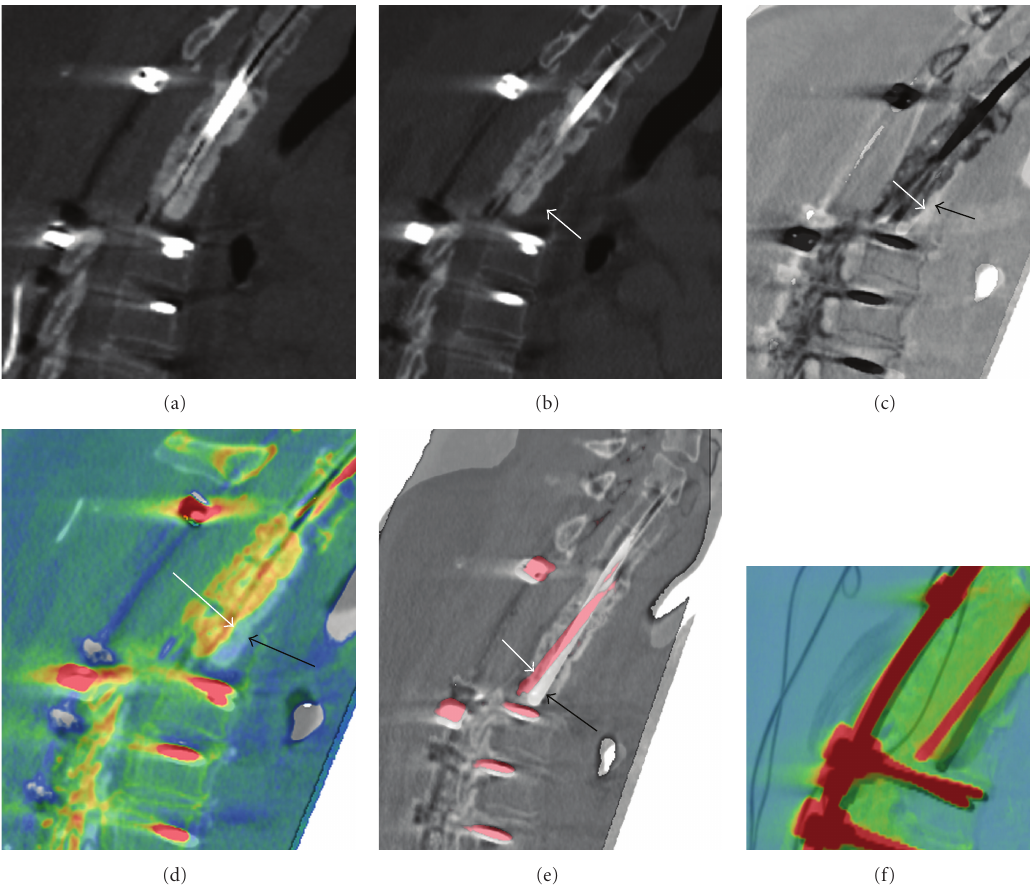
Figure 2: Case 2: 39-year-old man with renal cell carcinoma metastatic to the T2 through T4 vertebral bodies, s/p vertebrectomy with placement of Steinmann pin and methyl methacrylate graft. (a, b). Sequential sagittal noncontrast MDCT studies 3 months apart demonstrate subtle posterior migration of the Steinmann pin and methyl methacrylate graft. Arrow in (b) points to initial position of the graft. (c, d). Sagittal co-registered MDCT studies (windowed to view methyl methacrylate). Posterior migration of the methyl methacrylate graft; initial position (black arrow) and position on followup, (white arrow). (e) Sagittal coregistered MDCT studies (windowed to view instrumentation). Posterior migration of the Steinmann pin; initial position (black arrow) and position on followup (white arrow). (f). MIP (maximal intensity projection). Posterior migration of the Steinmann pin; original position: black color, followup: red